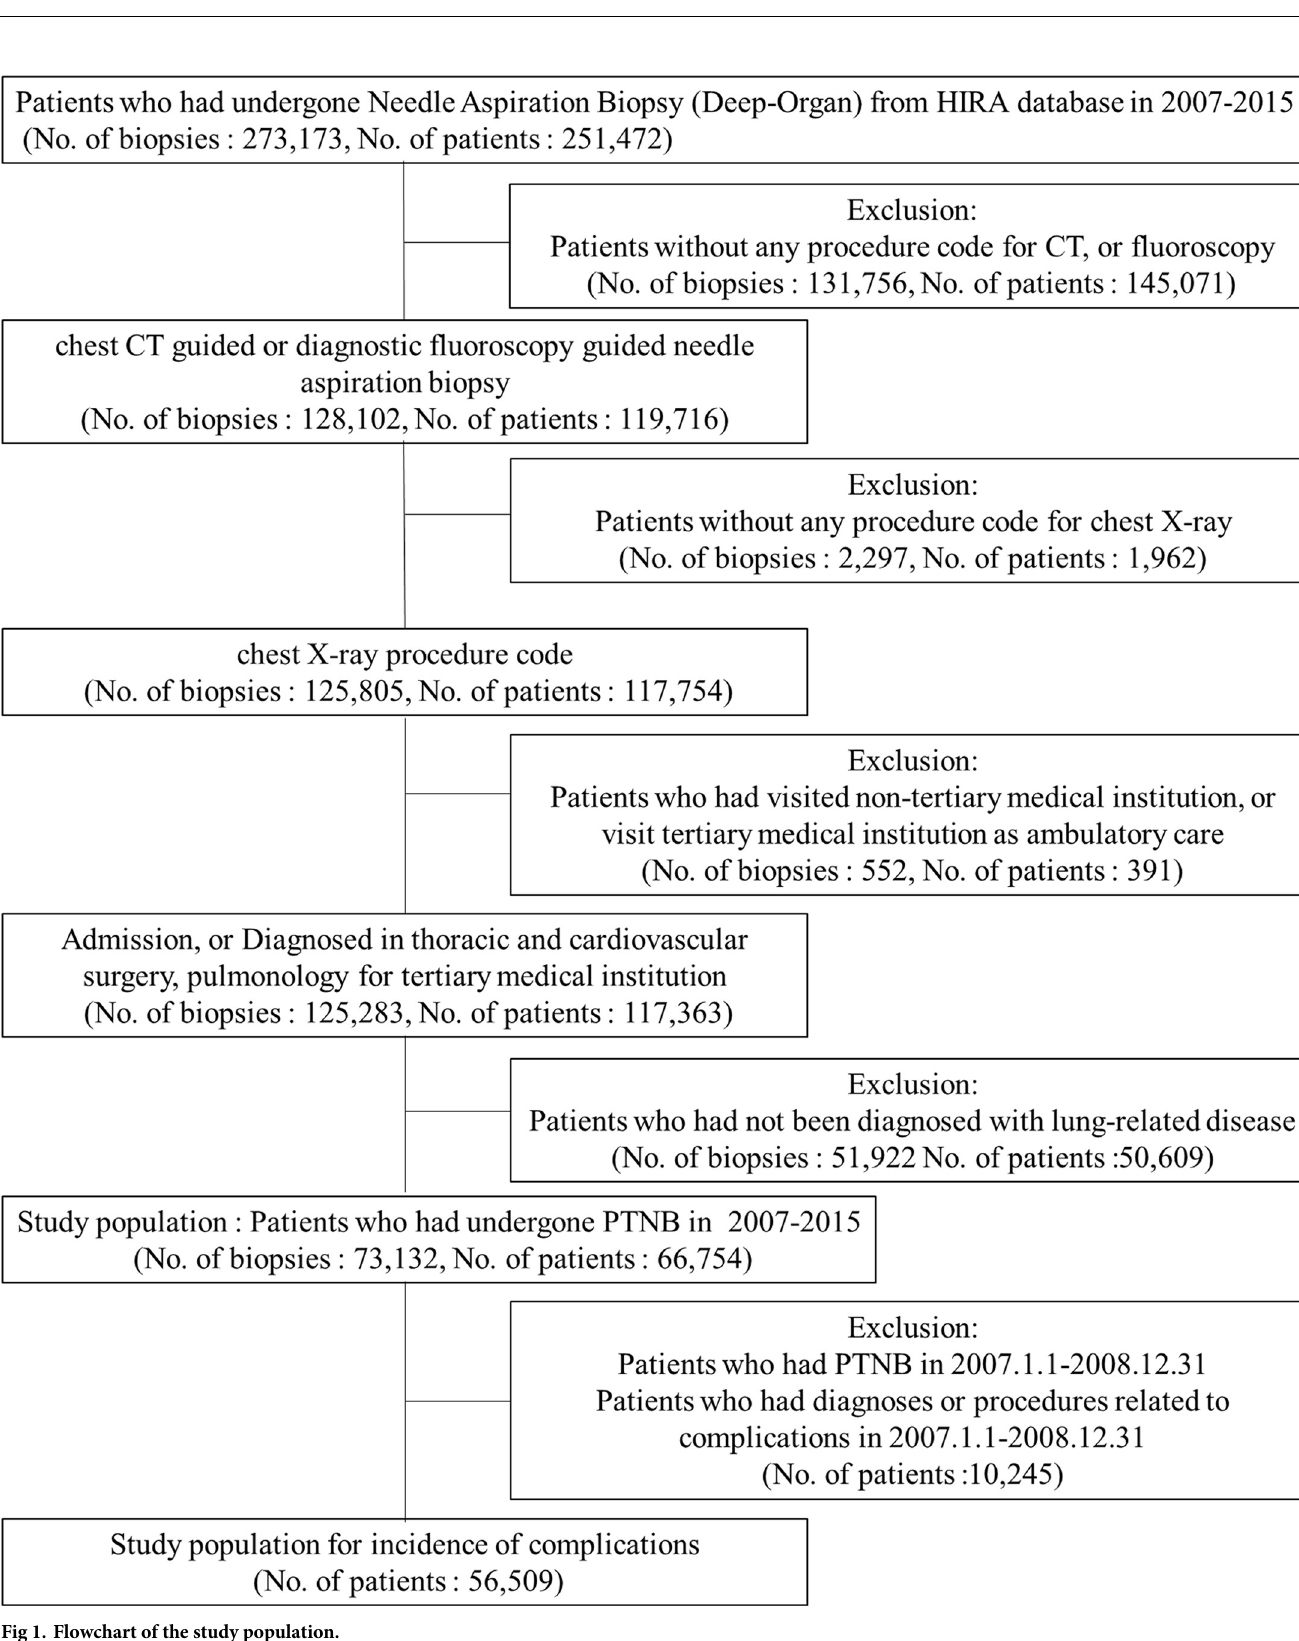
Fig 1. Flowchart of the study population.